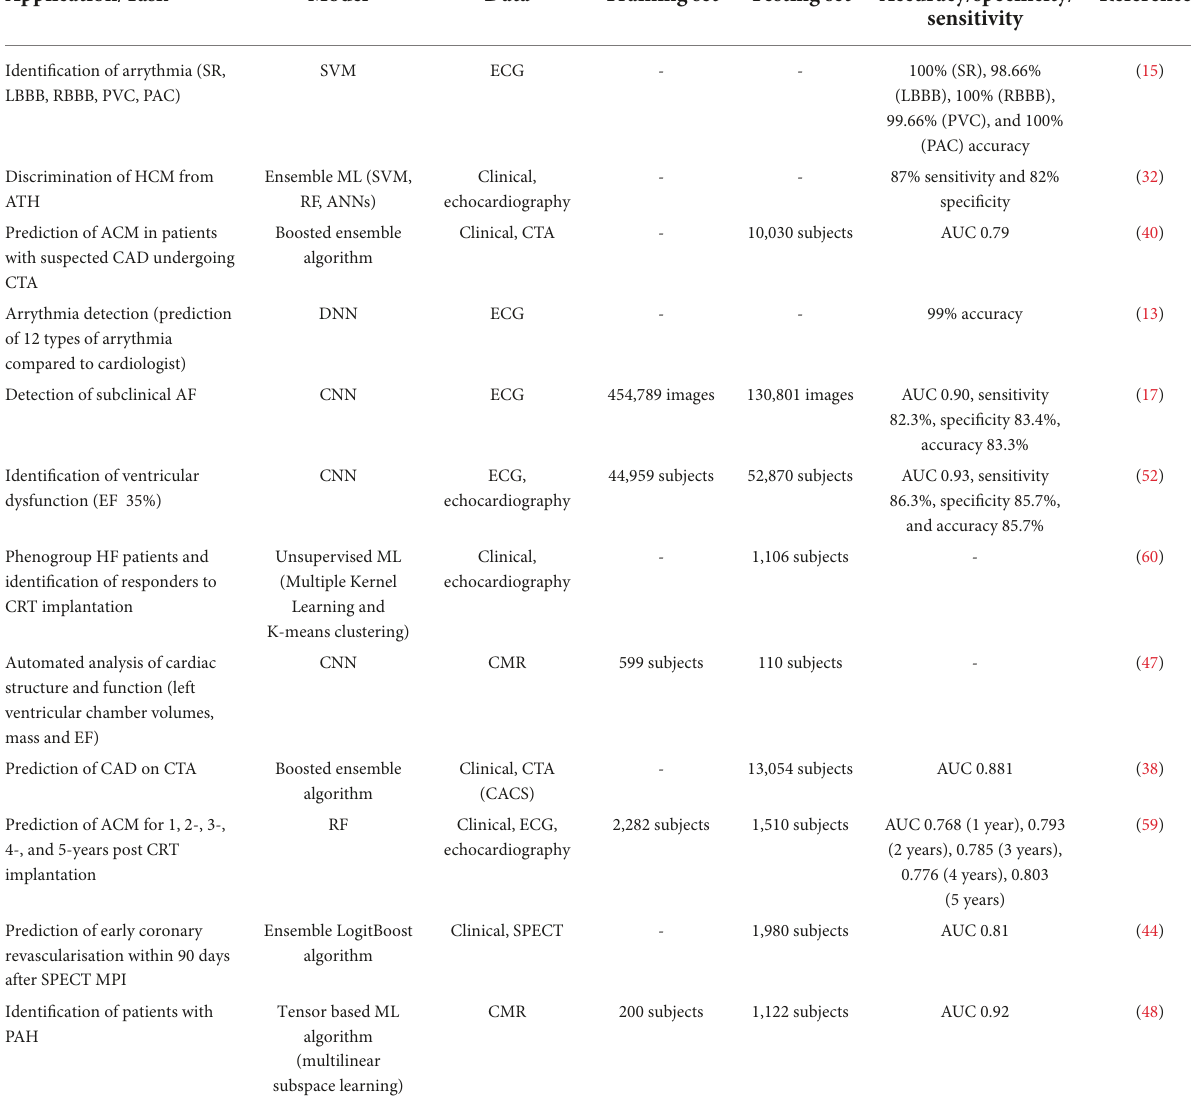
TABLE 3 Overview of the use of AI in